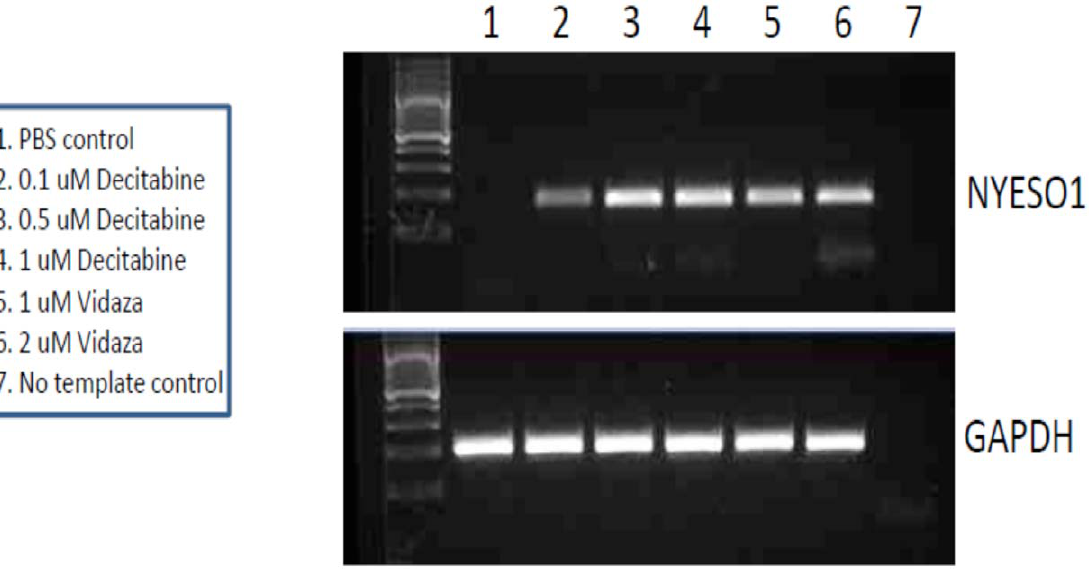
Figure 6. Induction of NY-ESO-1 by decitabine and 5-azacytidine. Photomicrograph showing the ability of decitabine and 5-azacytidine to induce of NY-ESO-1 in vitro in MCF-7